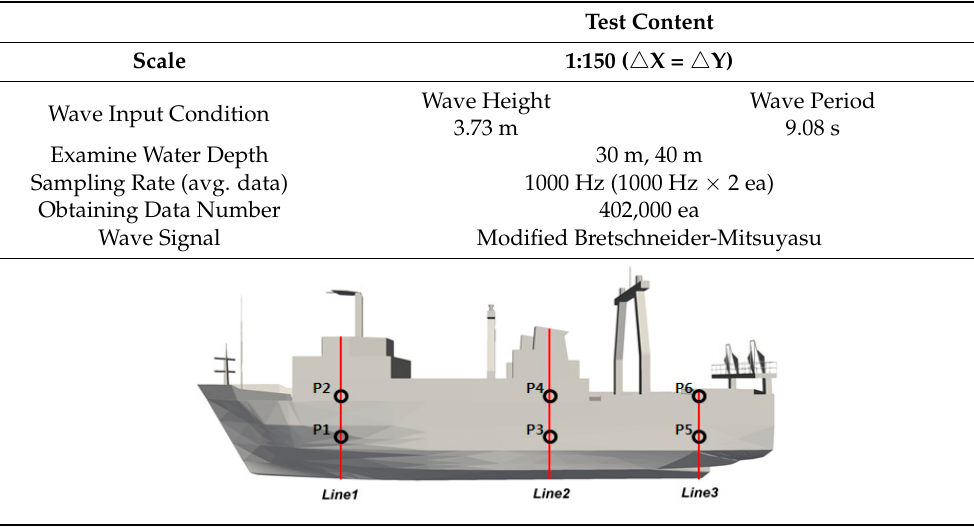
Figure 5. Experiment setup for the two-dimensional cross-sectional wave flume test.